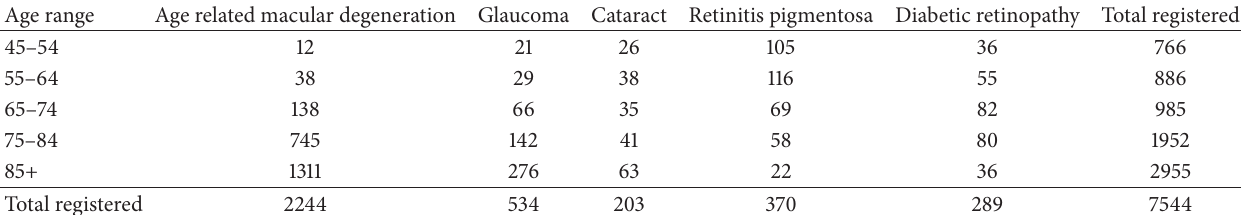
Table 1: Numbers of those registered as blind in the Republic of Ireland according to age and category in 2007/2008. Age